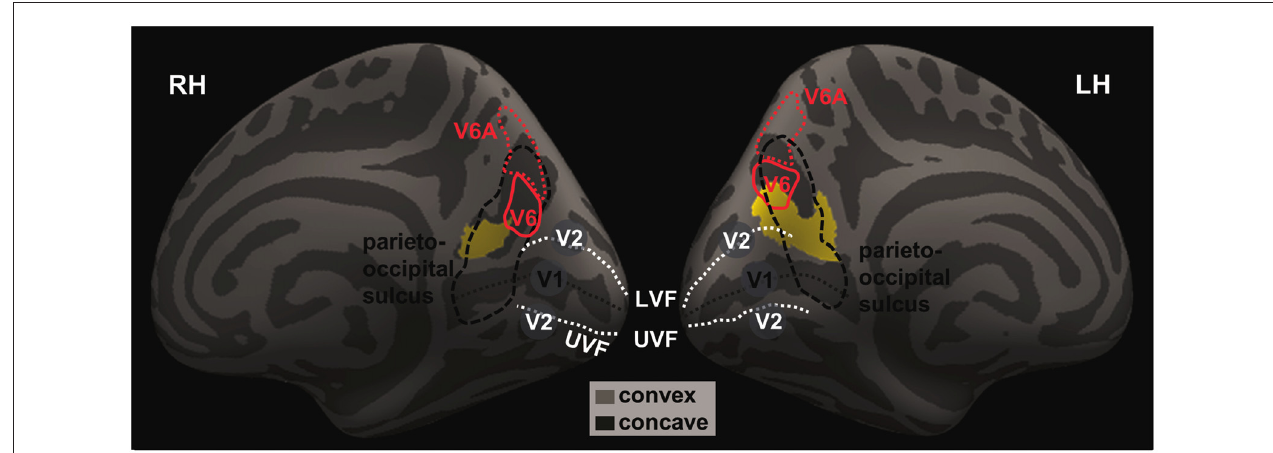
FIGURE 2 | The projected left and right GM volumes are overlaid on inflated left (LH) and right (RH) hemispheres of the Freesurfer’s fsaverage surface. The parieto-occipital sulcus (thick dashed black line) runs downward on the medial surface and joins the calcarine fissure (thin dashed black line) below, marking the boundary between the precuneus and cuneus and between the parietal and occipital lobes. In humans, area V6 occupies the most dorsal part of the parieto-occipital sulcus (Pitzalis et al., 2015). The medial and lateral parts of V6 each represents the peripheral and central visual fields; and the dorsal and ventral parts of the V6 each represents the upper and lower visual fields. The white dashed lines mark the approximate boundaries between V1 and V2. The lower/upper visual fields of V1 and V2 are represented in the dorsal/ventral bank of the calcarine sulcus. The central visual fields of V1 and V2 and represented toward the occipital pole while the peripheral visual fields are represented anteriorly in adjacence to the parieto-occipital sulcus. Thus, it appears that the identified clusters are both located in the occipital and parietal cortices that represent the lower, peripheral visual